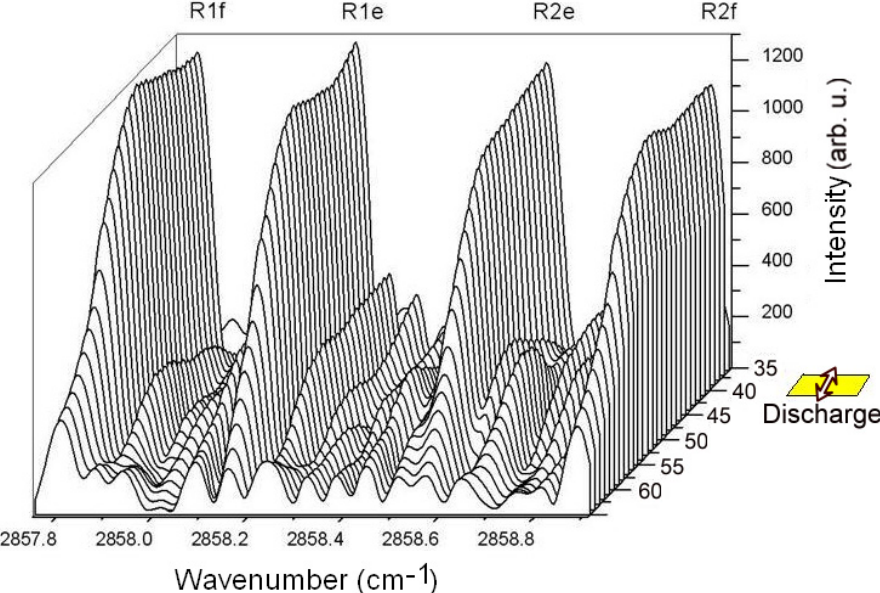
Figure 30. The time profile of CH radical at 2858 cm − 1 . The time interval of the discharge pulse is marked in yellow.